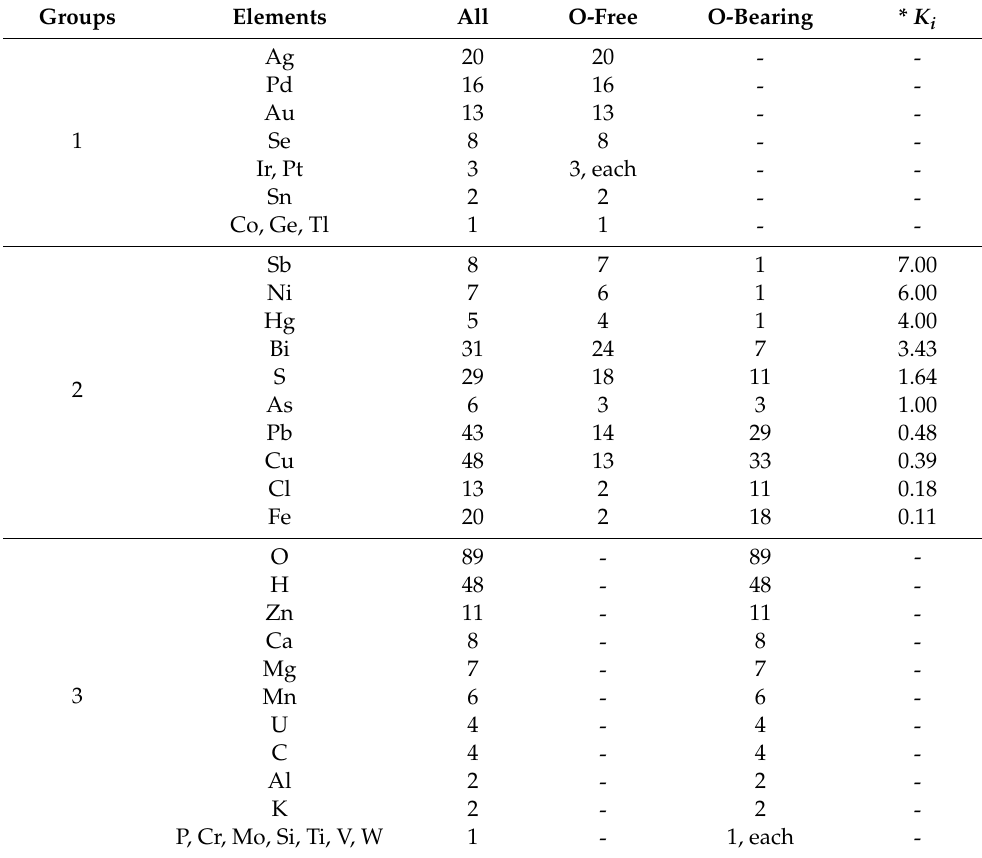
Table 2. The species-defining elements of Te minerals separated into three groups: (1) All minerals, (2) O-free, and (3) O-bearing minerals.